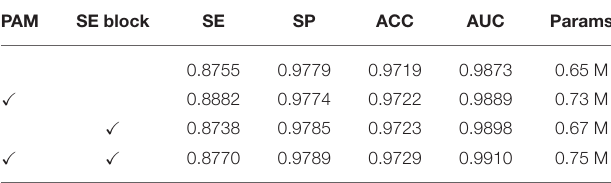
TABLE 7 | Ablation study for PAM and SE block.